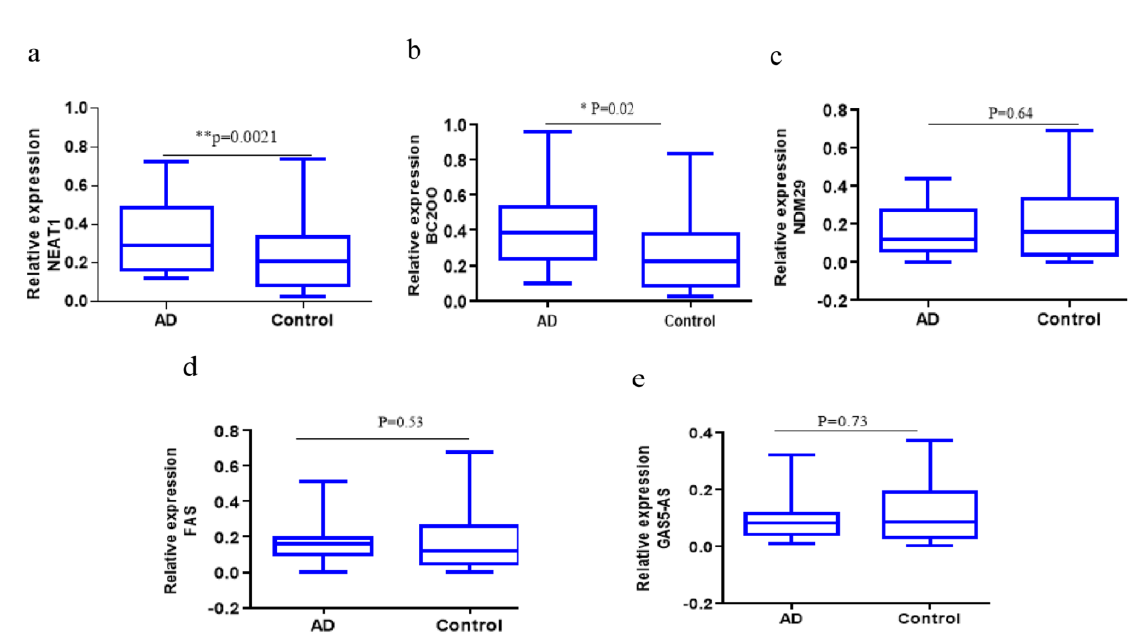
Figure 2: Plasma levels of the lncRNAs were quantified by qRT-PCR. The levels of a ) NEAT1, b ) BC200, c ) NDM29, d ) FAS-AS1 and e ) GAS5-AS1 were compared in plasma samples of AD patients and healthy controls. A two-tailed unpaired t-test was performed.